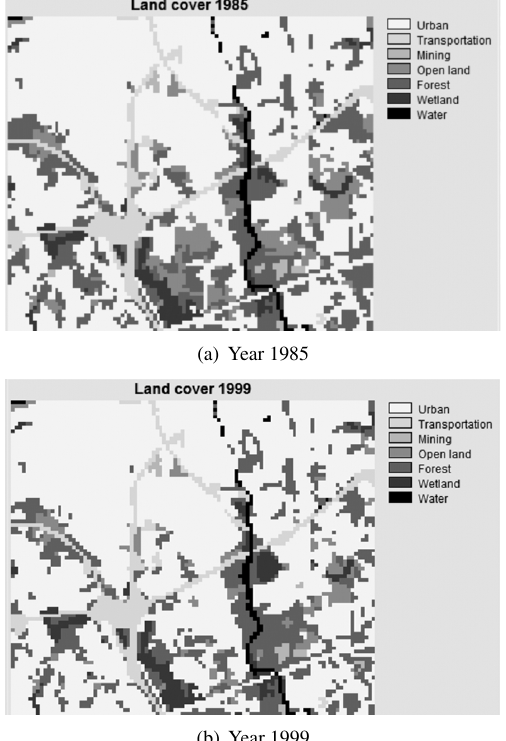
Fig. 3: The two land-cover maps compared